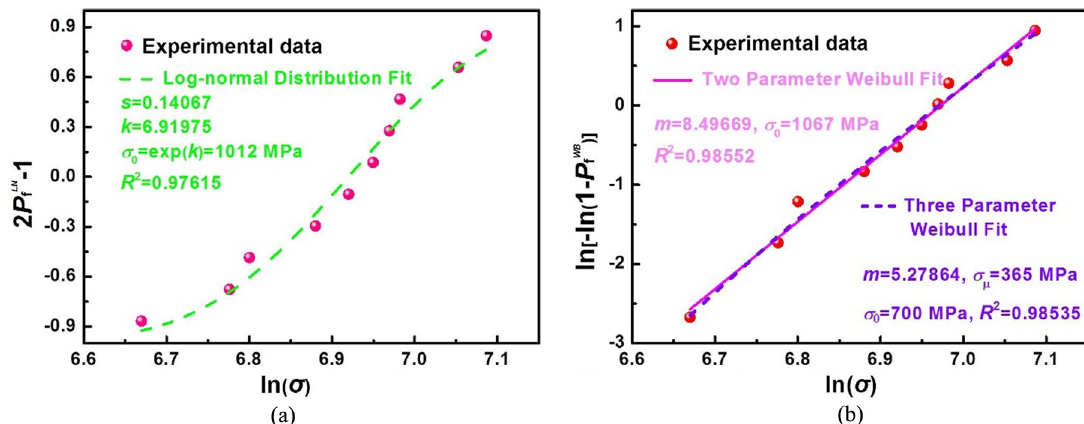
Figure 4. (a) Log-normal poltting and (b) Weibull plotting of the tensile strength of amorphous melt-extracted Gd